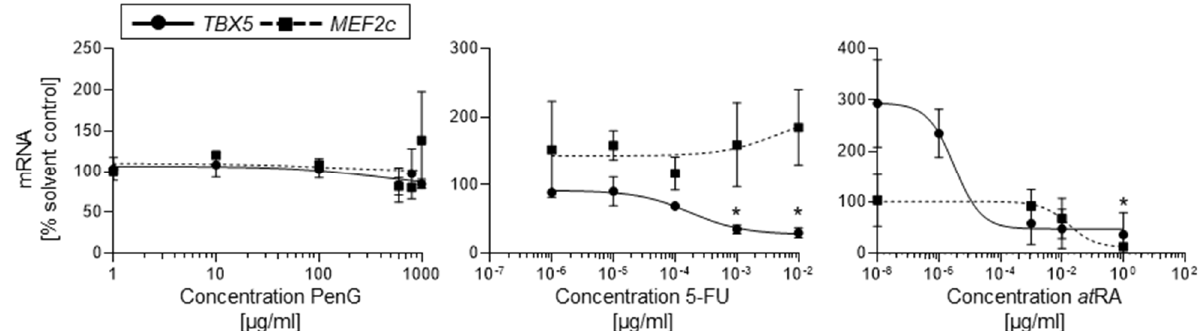
Figure 5. Treatment with embryotoxicants 5-FU and at RA impeded cardiomyocyte differentiation as measured by day 10 TBX5 gene expression in hiPSCs. hiPSCs were treated with different concentrations of 5-FU, at RA, or PenG and evaluated for TBX5 or MEF2c expression via qPCR. Data points represent means of three independent experiments ± SD. Inhibition of differentiation (ID50) was determined from dose–response curves as a 50% reduction in gene expression in the control. hiPSC, human induced pluripotent stem cell; 5-FU, 5-fluorouracil; at RA, all-trans retinoic acid; PenG, penicillin G. *: p < 0.05 = the lowest concentration significantly below the untreated hiPSC control group as determined by One-Way Cells exposed to at RA also showed a dose-dependent downregulation of TBX5 mRNA expression. In these cultures, exposure featured significantly downregulated TBX5 beyond the determined ID50 value of 3.28 × 10 − 6 μ g/mL (Figure 5). However, at RA